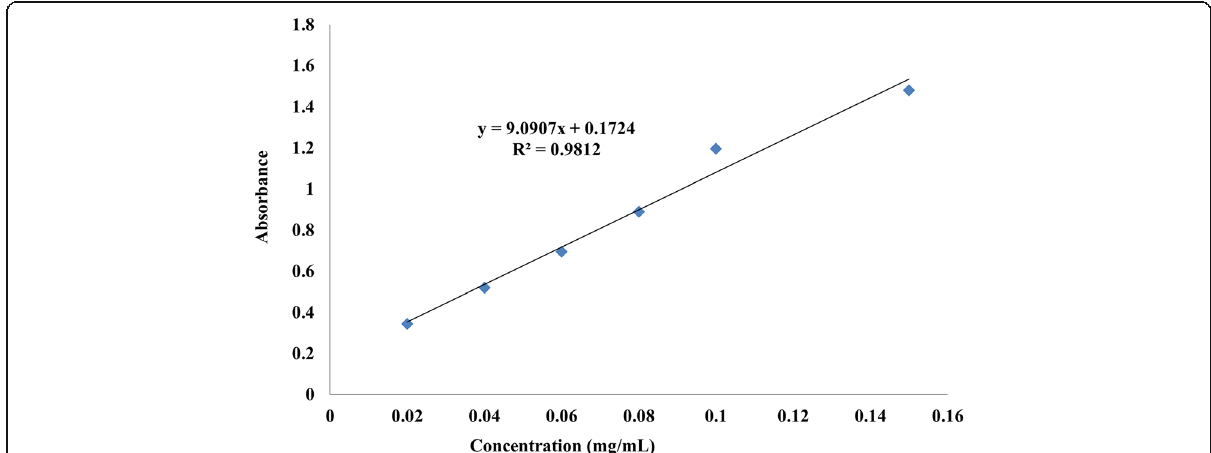
Fig. 1 Total phenolic content determination of Merremia umbellata extract with the help of gallic acid standard calibration curve